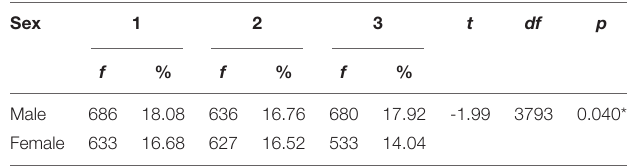
TABLE 10 | t -Test by sex between performance levels 1, 2, and